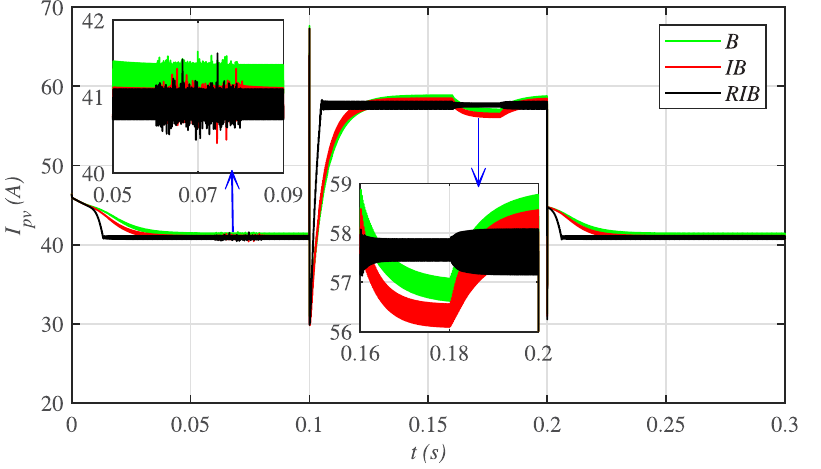
Fig 23. PV array comparative currents under case